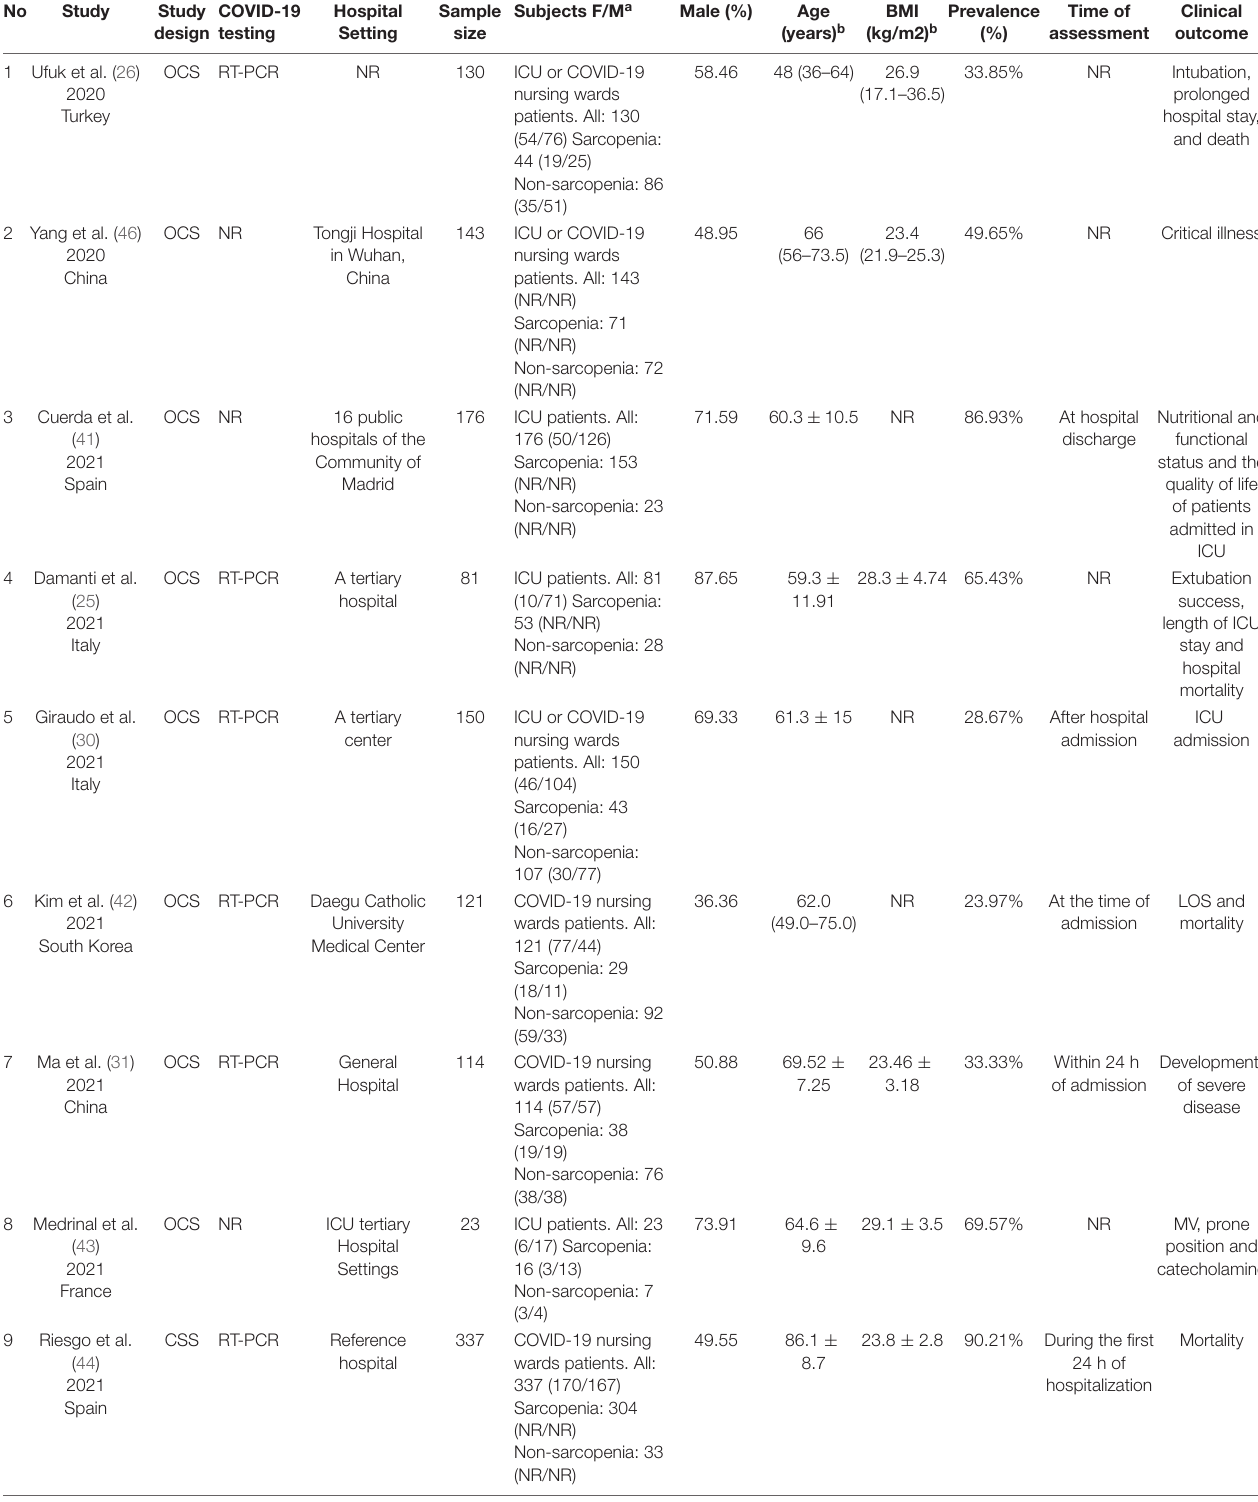
TABLE 1 | Main characteristics of the studies included in the